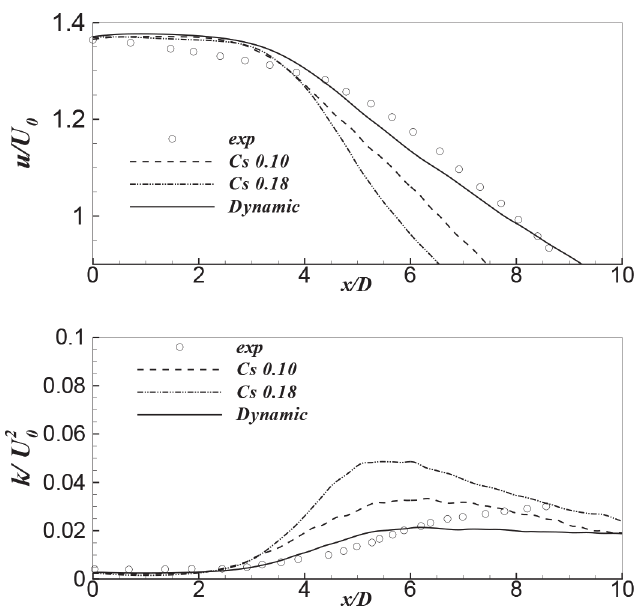
Figure 9 - Streamwise evolution of average velocity and turbulent kinetic energy profiles for the cold jet. The experimental results are extracted from Chen et al.